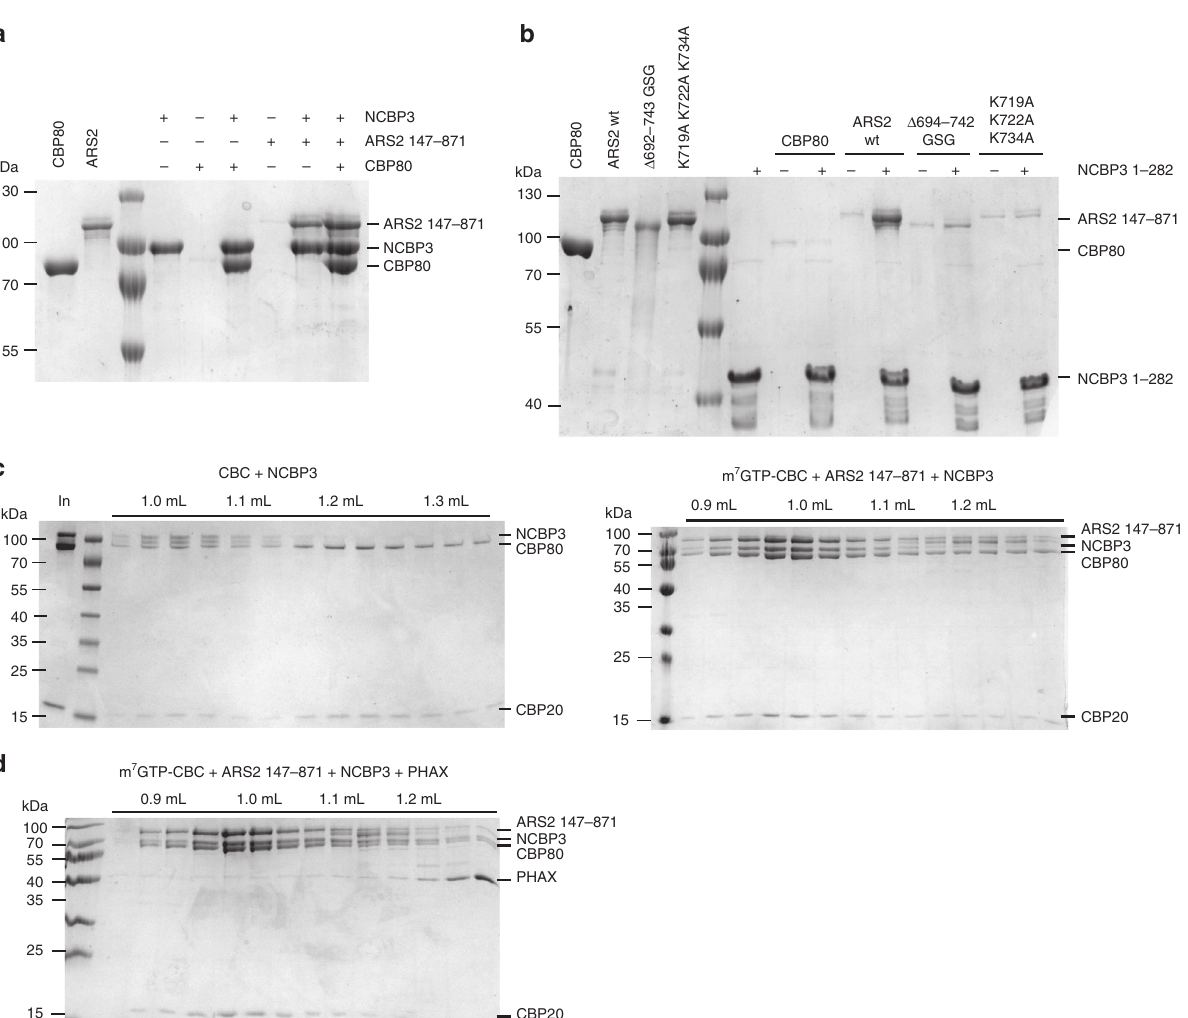
Fig. 6 NCBP3 forms a CBC – ARS2 – NCBP3 complex. a , b m 7 GTP pull-down of full-length NCBP3 ( a ) or NCBP3 1 – 282 ( b ) with ARS2 and/or CBP80. Puri fi ed recombinant NCBP3 constructs were immobilised on m 7 GTP sepharose before incubation with CBP80 and/or wild type or mutant ARS2 147 – 871 . Eluted fractions were analysed by Commassie-stained SDS-PAGE. c Coomassie-stained SDS-PAGE of CBC – NCBP3 and CBC – ARS2 – NCBP3 complexes analysed by gel fi ltration. The puri fi ed recombinant proteins were mixed, subjected to gel fi ltration and the individual protein-containing fractions were analysed by SDS-PAGE. d Coomassie-stained SDS-PAGE of CBC – ARS2 – PHAX plus NCBP3 analysed by gel fi ltration. CBC – ARS2 – PHAX was mixed with molar excess of NCBP3, subjected to gel fi ltration and the individual fractions were analysed by